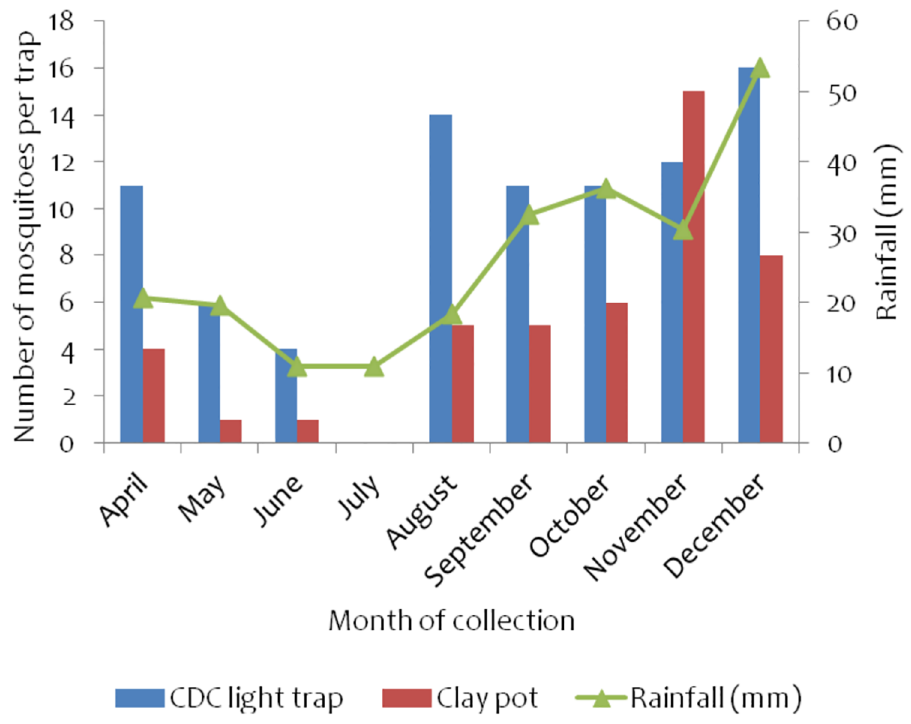
Fig 9. Monthly collection of anopheline mosquitoes in Natta-Mbisso village, Serengeti district monitored using CDC light traps and clay pot methods. The rainfalldata was obtainedfrom climate data library (http://iridl.ldeo.columbia.edu/maproom/).